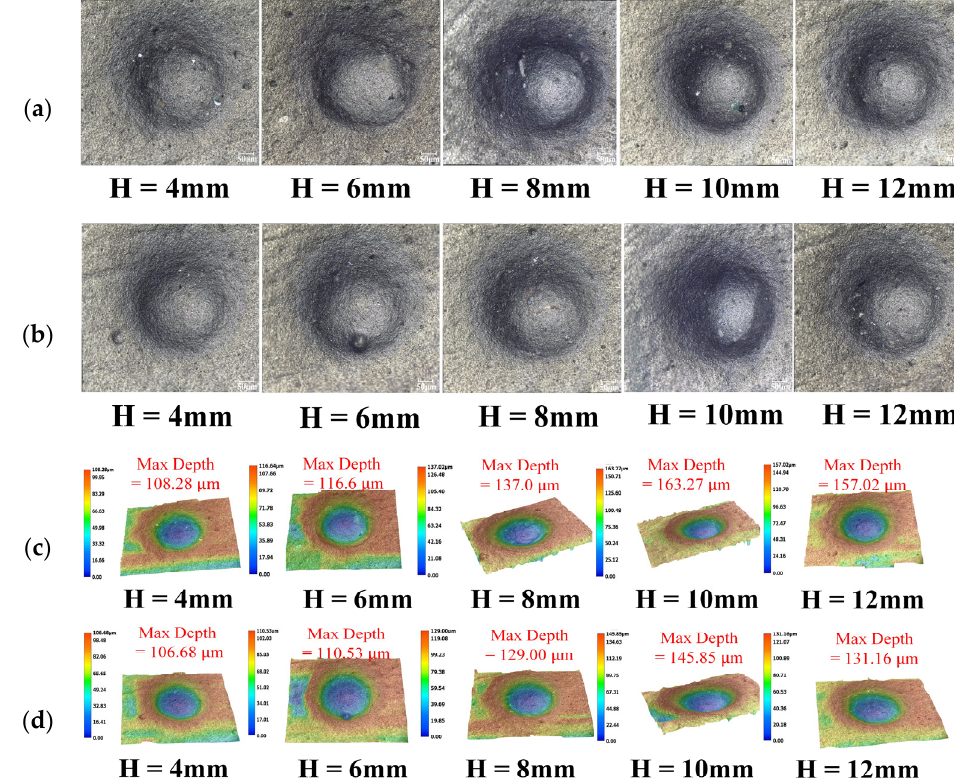
Figure 14. Erosion morphology and depth of cavities with and without self-excited oscillation under different standoffs: ( a ) Erosion morphology of SEO-AWJM, ( b ) Erosion morphology of AWJM, ( c ) Erosion depth of SEO-AWJM, ( d ) Erosion depth of AWJM.